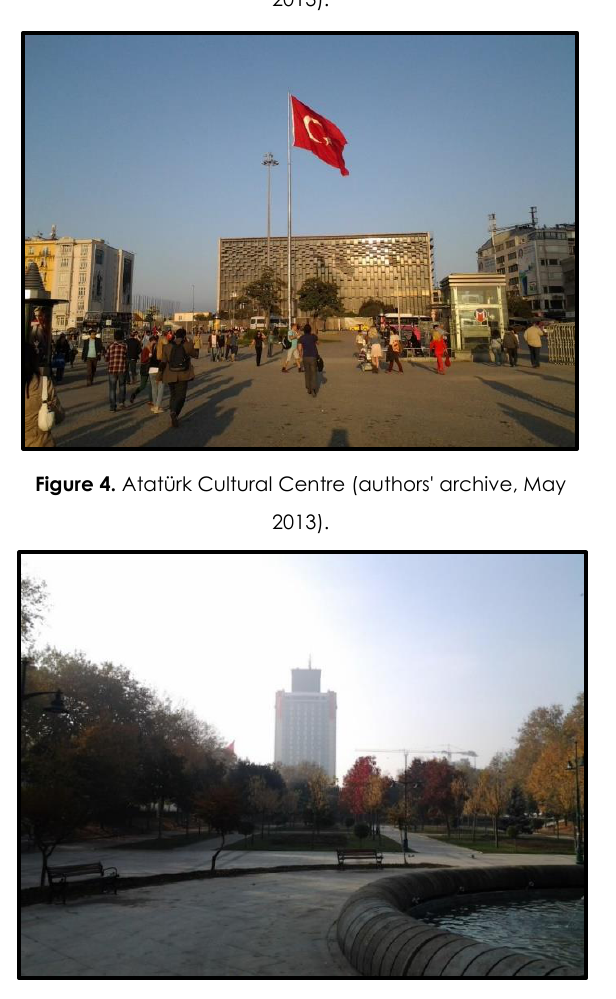
Figure 5. A view from inside the park, with the Marmara Hotel on the background (authors' archive, October 2013).